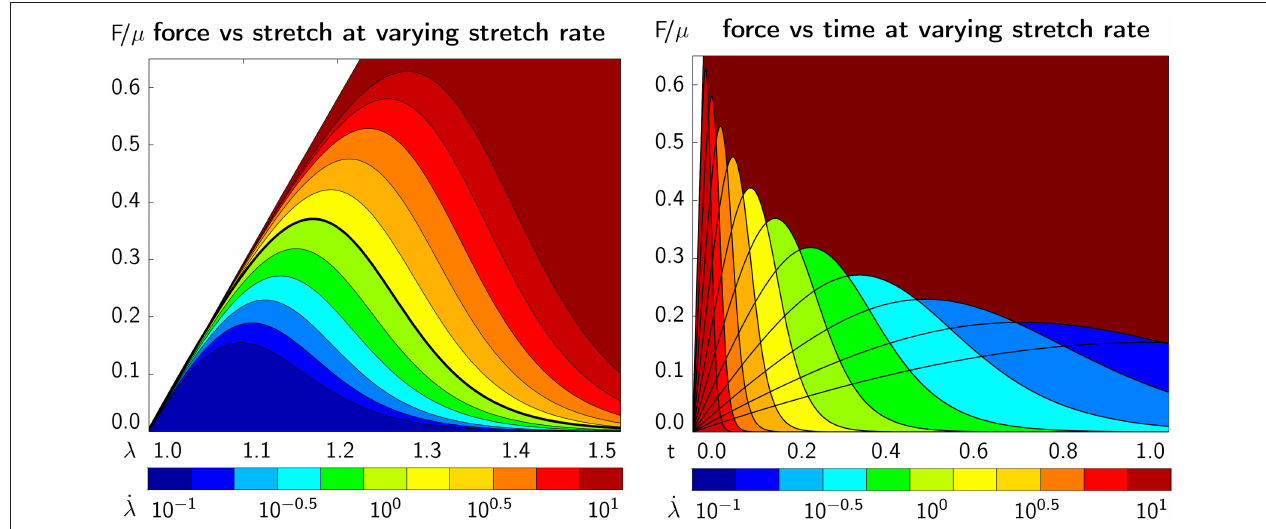
FIGURE 10 | Continuum axonal damage. Axonal force vs. axonal stretch (Left) and time (Right) at varying stretch rates and constant bond strength. The dark red area marks the elastic, undamaged regime. The graphs demonstrate an emergent feature of our transient crosslink model: For increasing stretch rates, the peak axonal force increases (Left) but is reached earlier in time (Right)